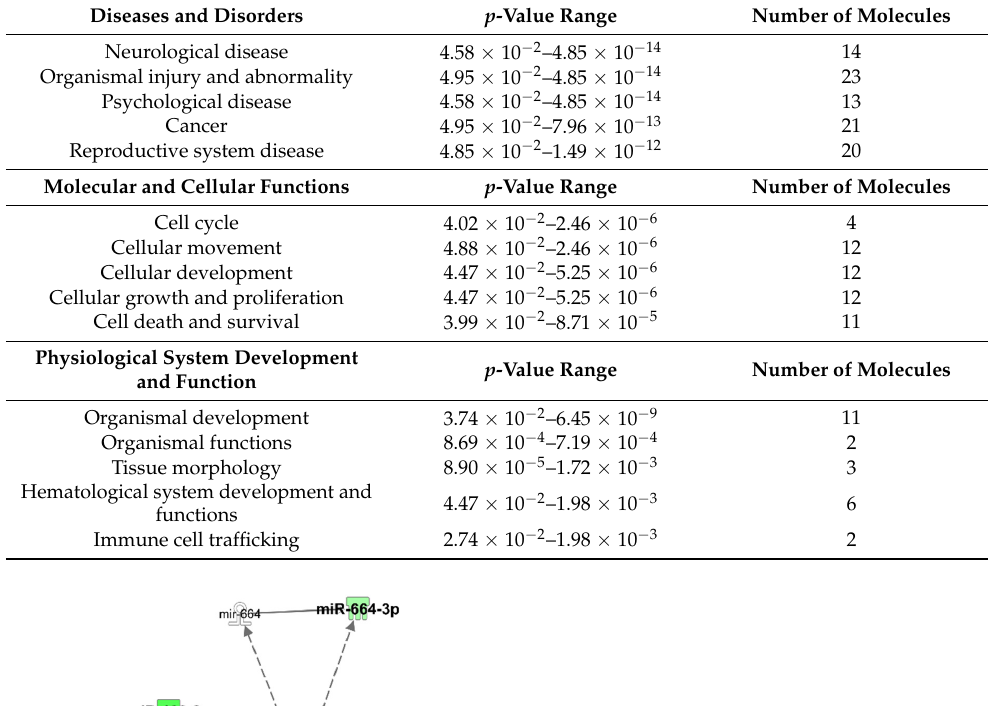
Table 3. Top IPA Biological Functions and Disease Pathway.